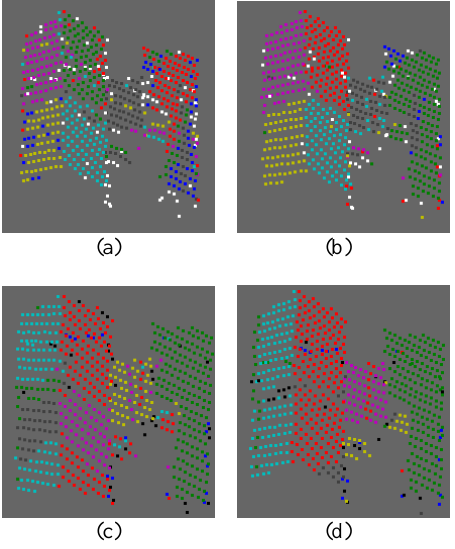
Figure 5. Planes detected by RANSAC. (a) t =0.02. (b) t =0.05. (c) t =0.1. (d) t